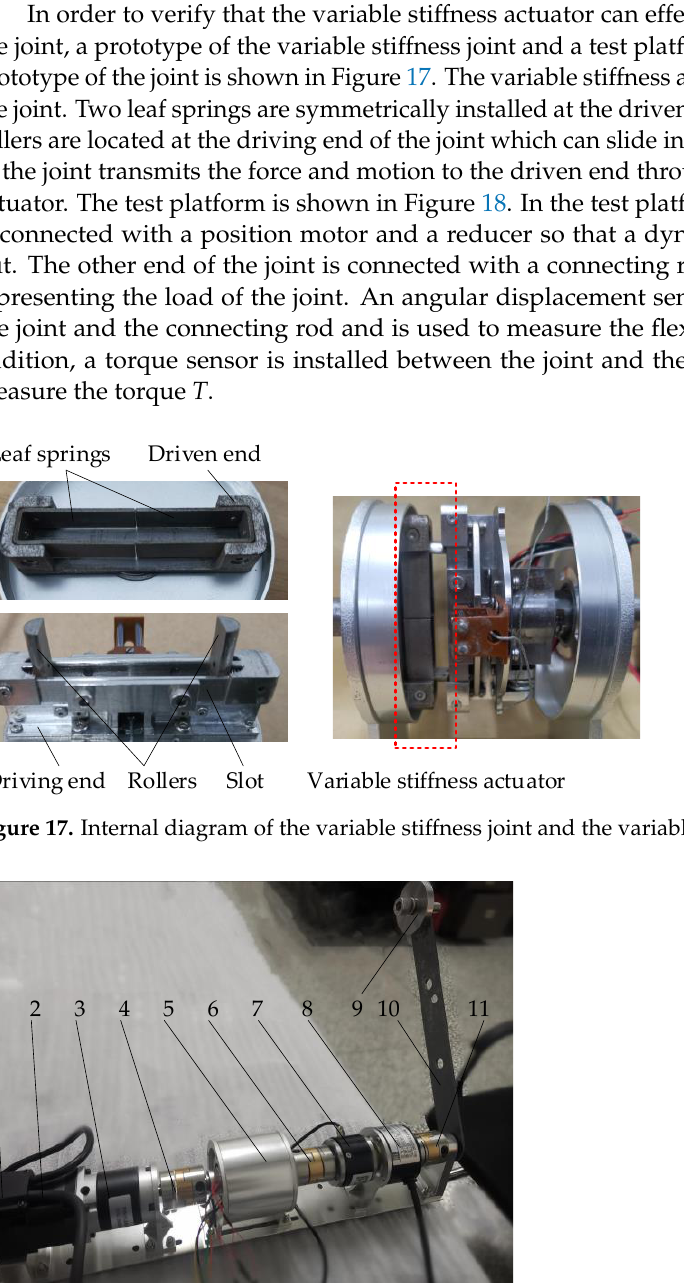
Figure 18. Test platform. 1 — motor encoder, 2 — position motor, 3 — reducer, 4 — coupling I, 5 — variable stiffness joint, 6 — coupling II, 7 — torque sensor, 8 — angular displacement sensor, 9 — counterweight, 10 — connecting rod, 11 — coupling III.